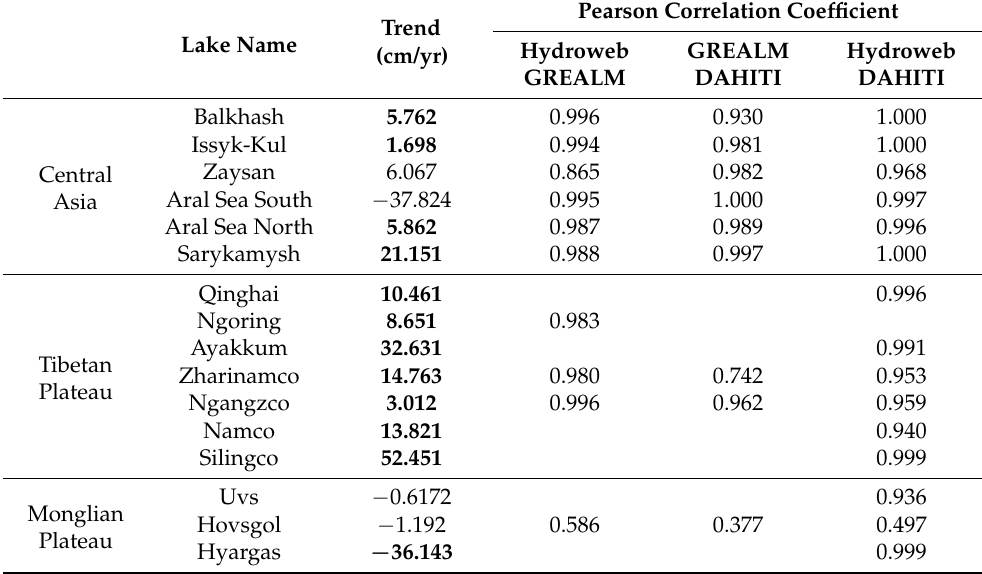
Table 2. Trends of lake water levels from the Hydroweb dataset during the period of 1992–2018 and Pearson correlation coefficients calculated between three altimetry datasets: The significance is shown in bold font. The blank in the table is due to a lack of data in the corresponding altimetry